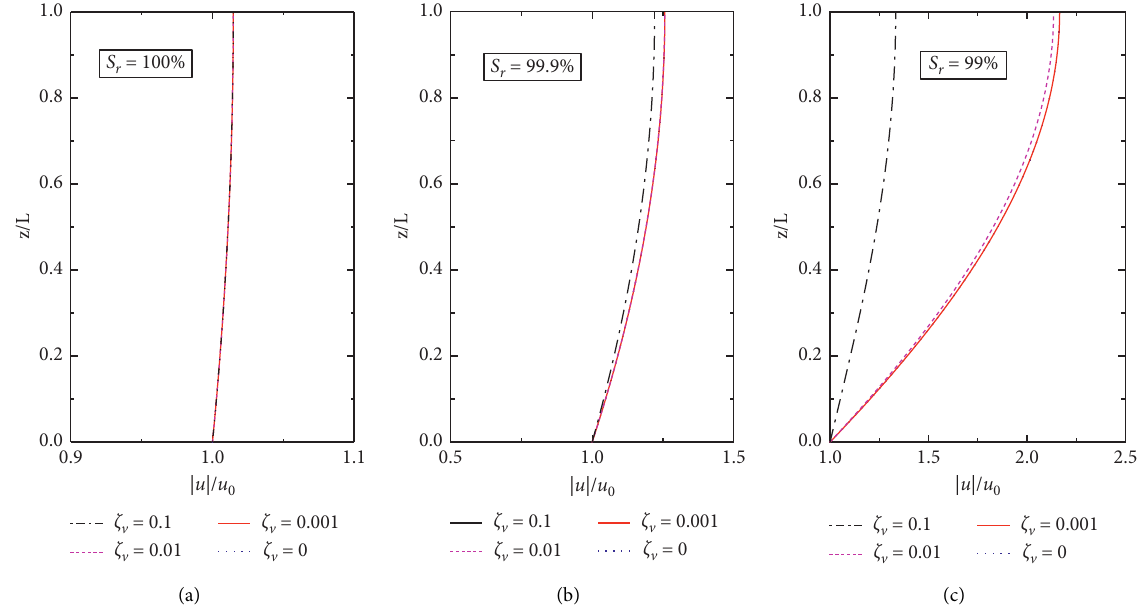
Figure 6: Distributions of amplification factor with depth for three specified saturation degrees (vertical